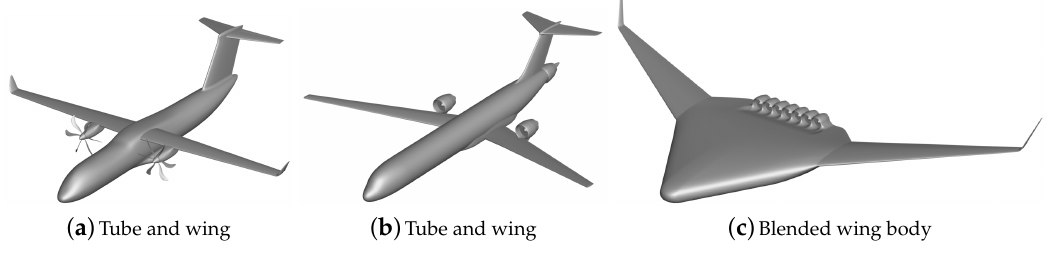
Figure 1. Reference aircraft designs. Table 1. Summary of the reference aircraft applications. Data from